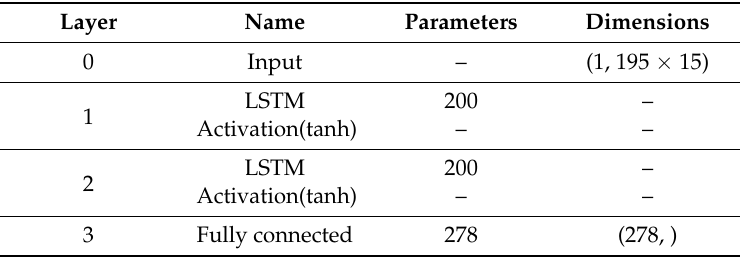
Table A3. Hyperparameters of the LSTM when α = 0.70